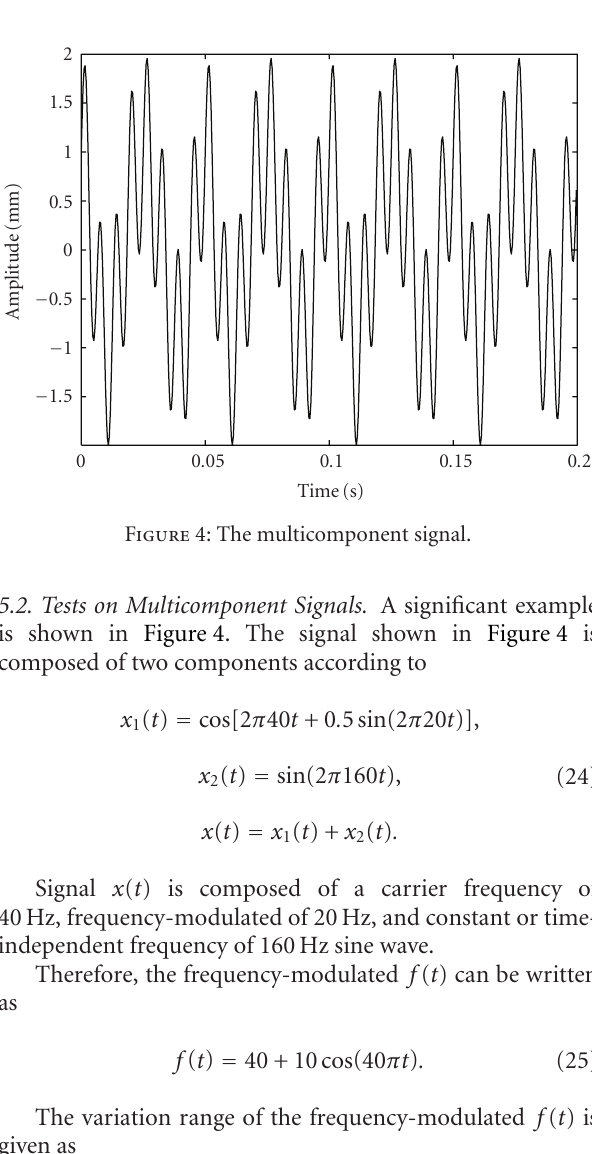
Figure 3: THT spectrum of monocomponent signal.